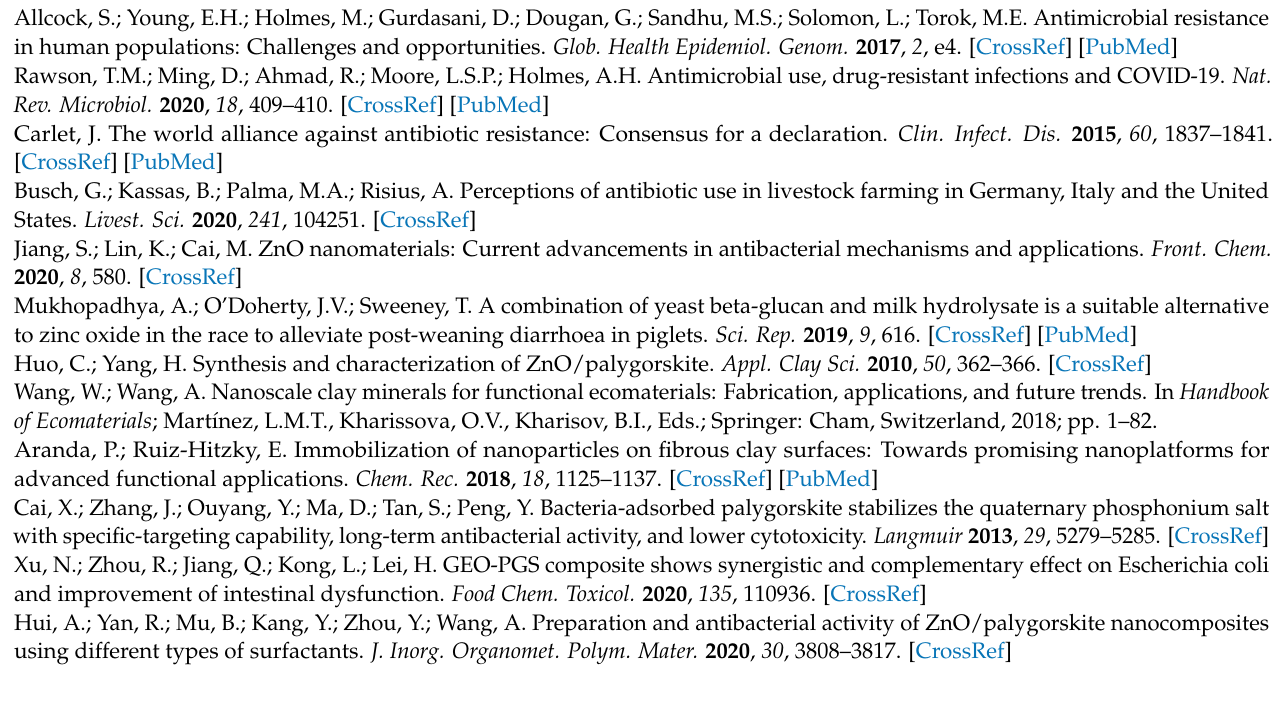
ZnO/APT. Figure S2: FTIR spectra of MAG, ZnO/APT and C–ZnO/APT nanocomposites with CTAB concentrations of 0.1%, 0.5%, 1% and 2.5%; Figure S3: Zeta potential of C–ZnO/APT nanocomposites with CTAB concentrations of 0.1%, 0.5%, 1% and 2.5%; Table S1: MIC values of MAG,